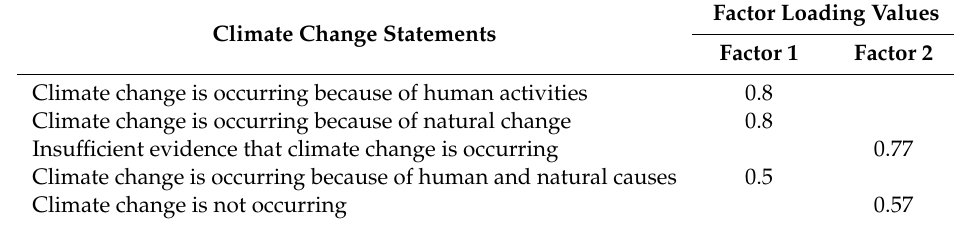
Table 3. Principal axis factoring results.